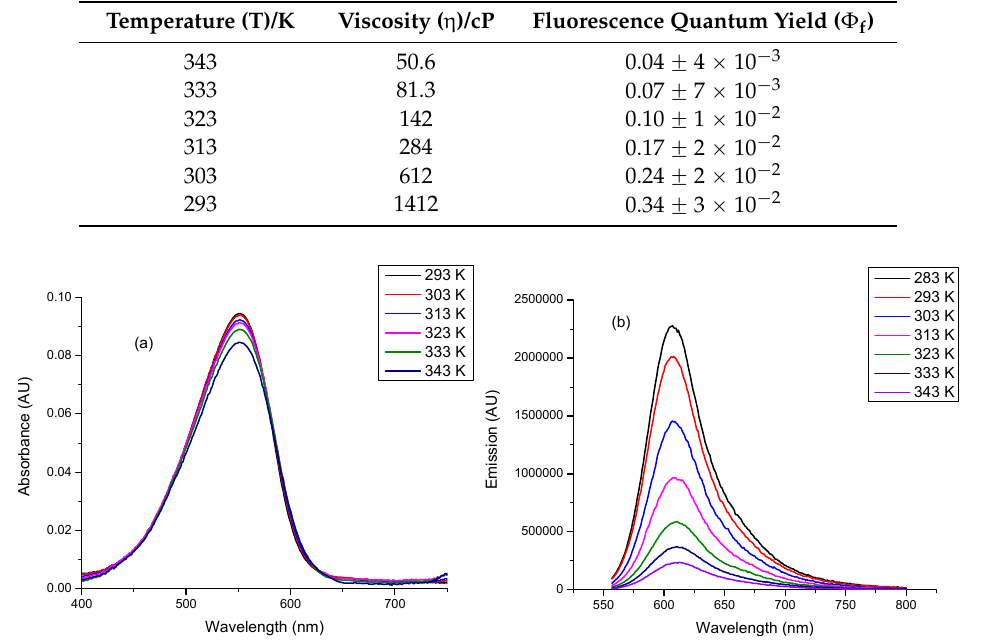
Table 1. Fluorescence quantum yield ( Φ f ) of dU-BZ and viscosity ( η ) as a function of temperature (T) in 99% glycerol/1% methanol ( v / v ) solution.